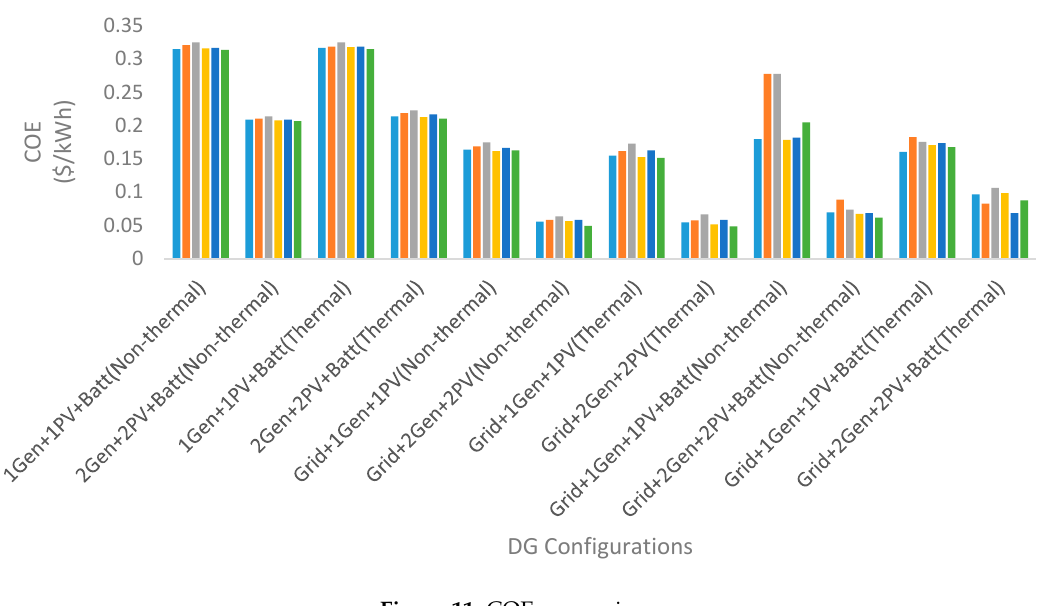
Figure 11. COE comparison.